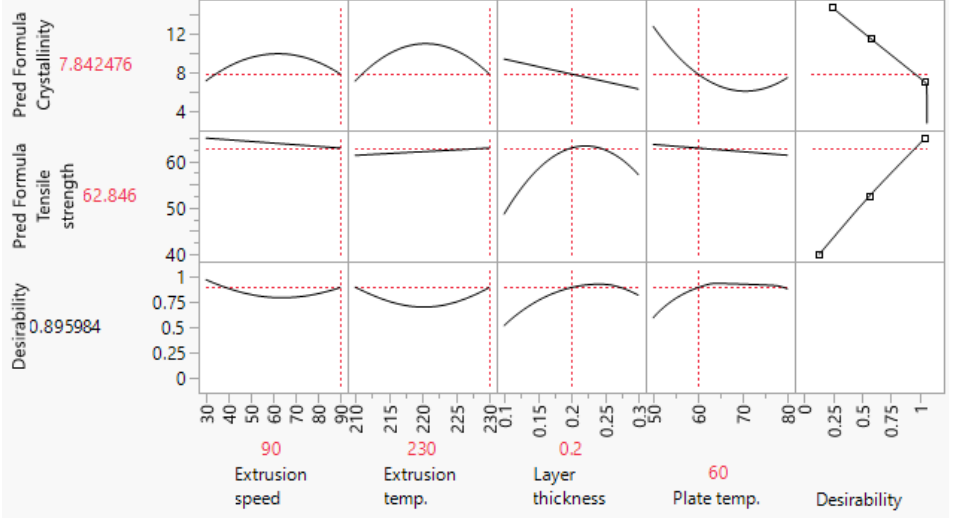
Figure 1. Optimization profiler showing FFF parameter settings which allow fabrication of scaffolds with low-level crystallinity (LLC) and high-tensile strength.